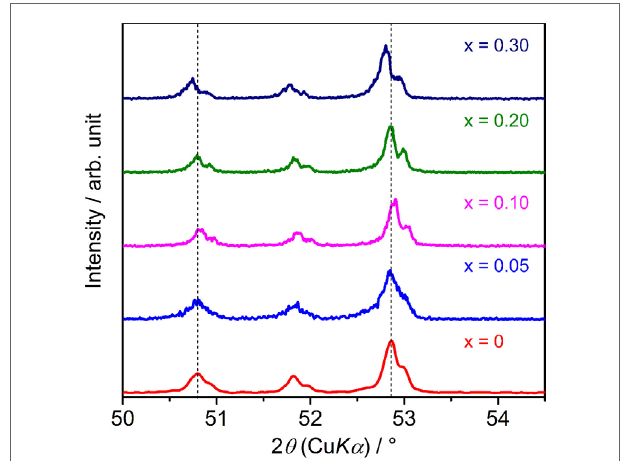
FigUre 2 | enlarged XrD patterns for sintered llBZT with different Ba contents x .